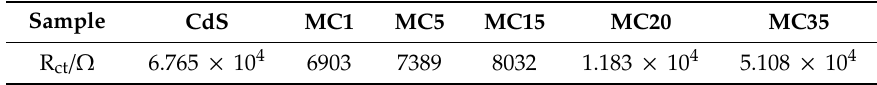
Table 1. Charge transfer resistances (R ct ) of cadmium sulfide (CdS) and molybdenum sulfide (MoS 2 ) / CdS nanocomposites.